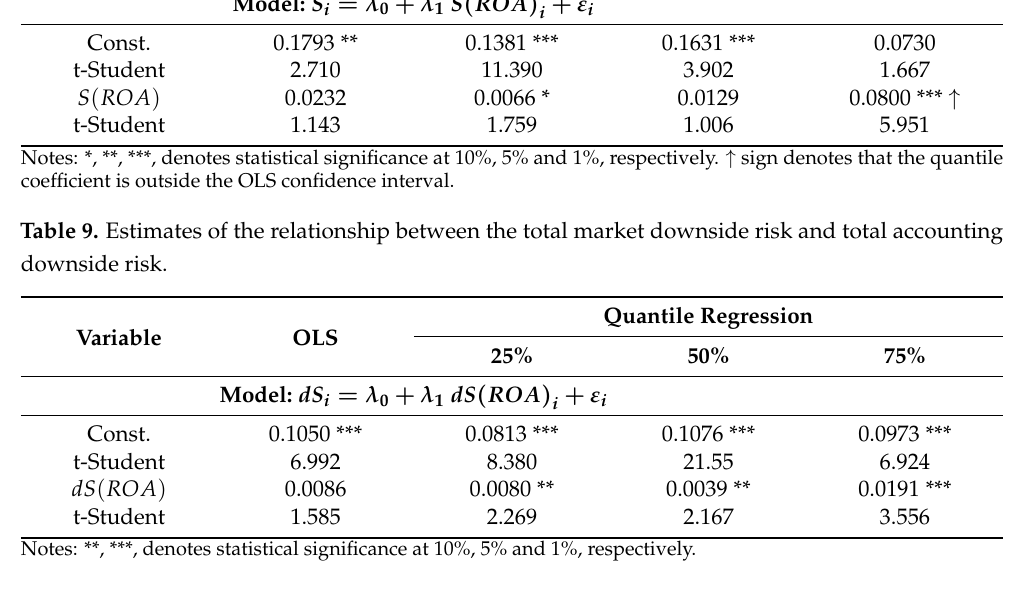
Table 10. Estimates of the relationship between systematic market risk and systematic accounting risk. Variable